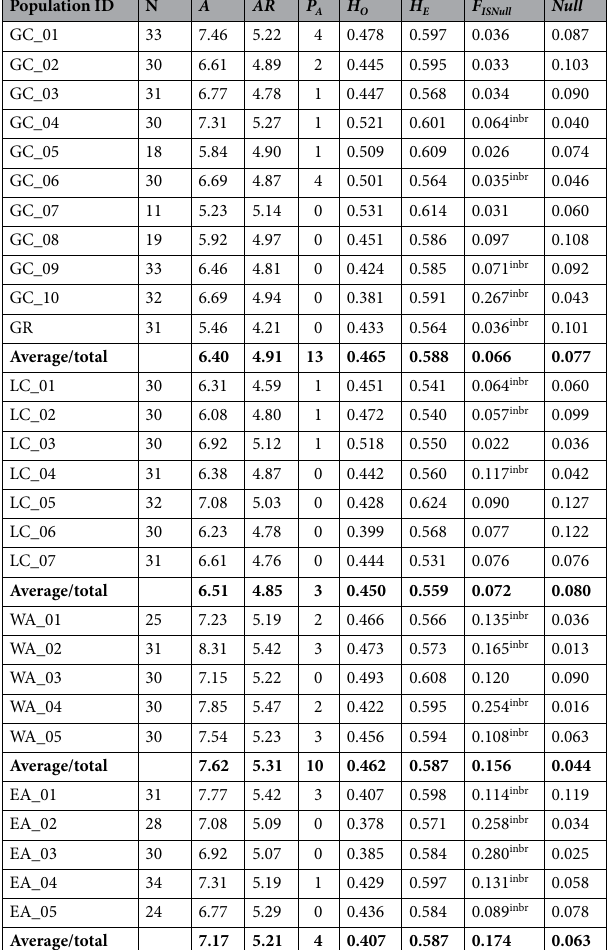
Table 1. Locations of natural populations of Scots pine investigated studied in this study along with summary of genetic variability estimated for each population across 13 nSSR loci (GC—the Greater